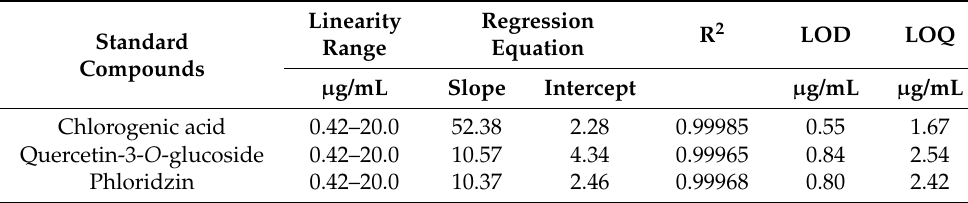
Table 2. Regression equation, R 2 , limits of detection (LOD), and limits of quantification (LOQ) of standard compounds analyzed by